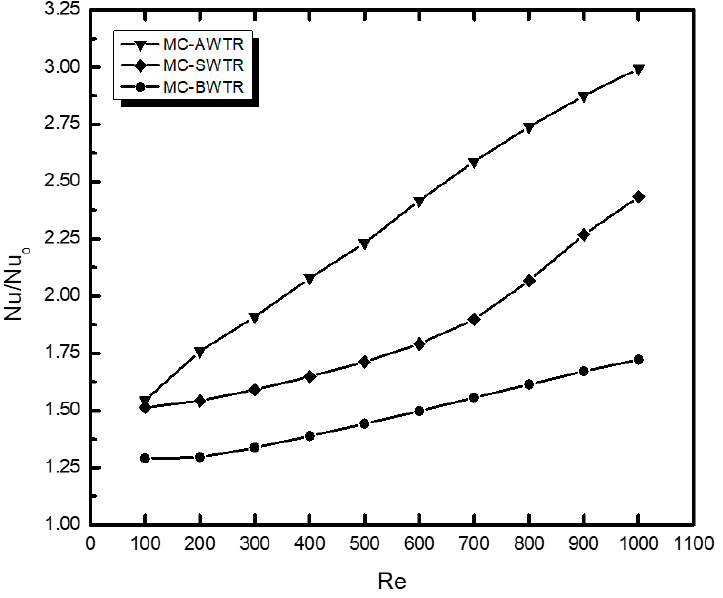
Figure 9. Comparison of Nusselt number ratio for different wall configurations MCHS.